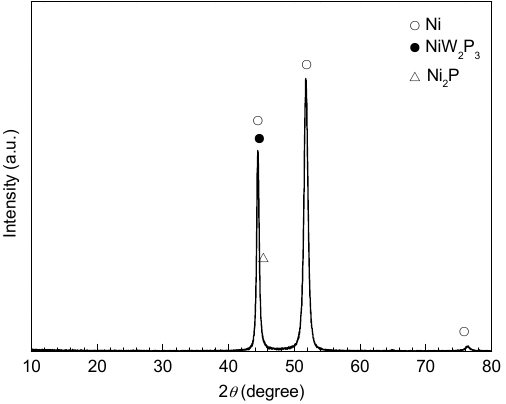
Figure 2. XRD spectra of the electrodeposited Ni-based alloy coating.